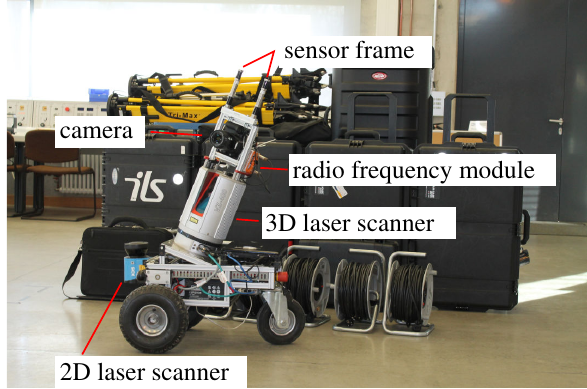
Figure 1: The Irma3D robot with the setup used in the